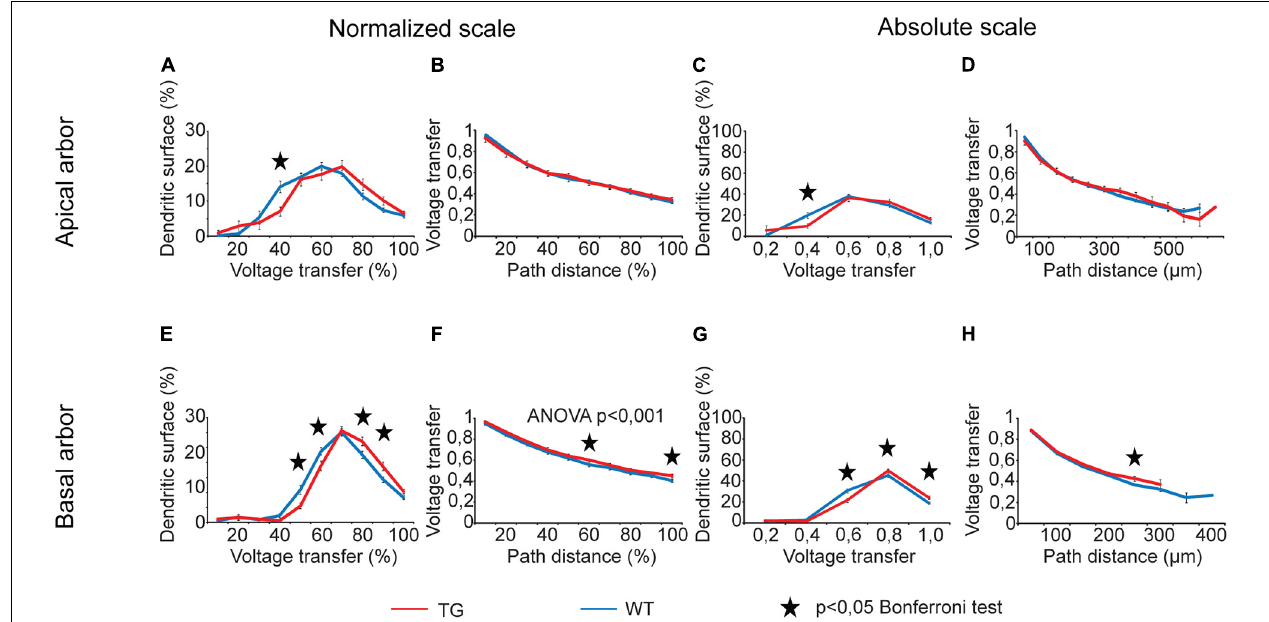
FIGURE 6 | Alterations in steady-state voltage transfers in advanced tauopathy. Comparison graphs showing alterations in steady-state voltage transfers of TG (red lines) neurons relative to control, WT neurons (blue lines). Overall statistical evaluations of comparison graphs were made by two-way ANOVA tests. Significance levels of these ANOVA tests were indicated where statistically significant overall alteration in comparison graphs was found (elsewhere p > 0.05). Asterisks mark path distance regions and transfer intervals with statistically significant differences between WT and TG neurons (Bonferroni post hoc test, p < 0.05). Distance regions and transfer intervals with less than 3–3 data points in TG-WT comparisons were omitted from statistical tests.